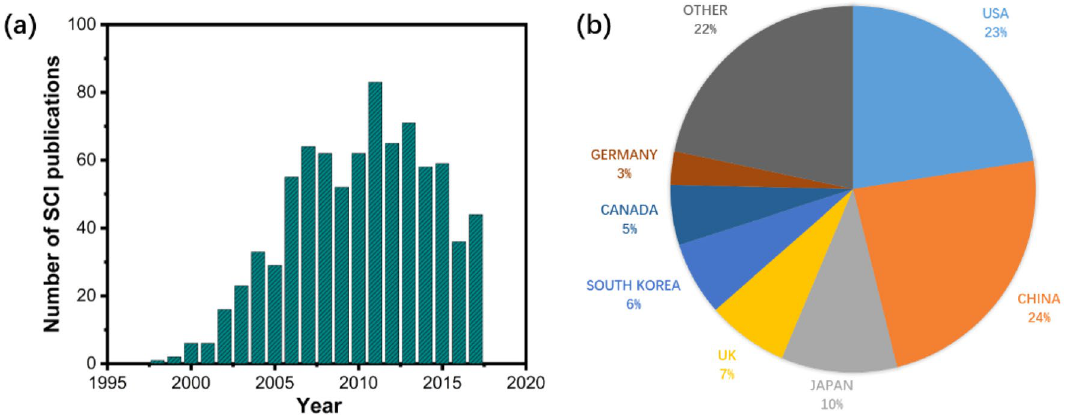
Fig. 1 a Number of SCI publications concerning SOFC anodes from 1999 to 2018, and b country distributions for publications about SOFC